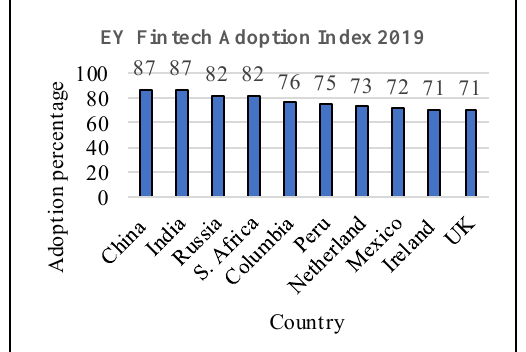
Fig. 6. Fintech Adoption Index by Country Source: EY FinTech Adoption Index